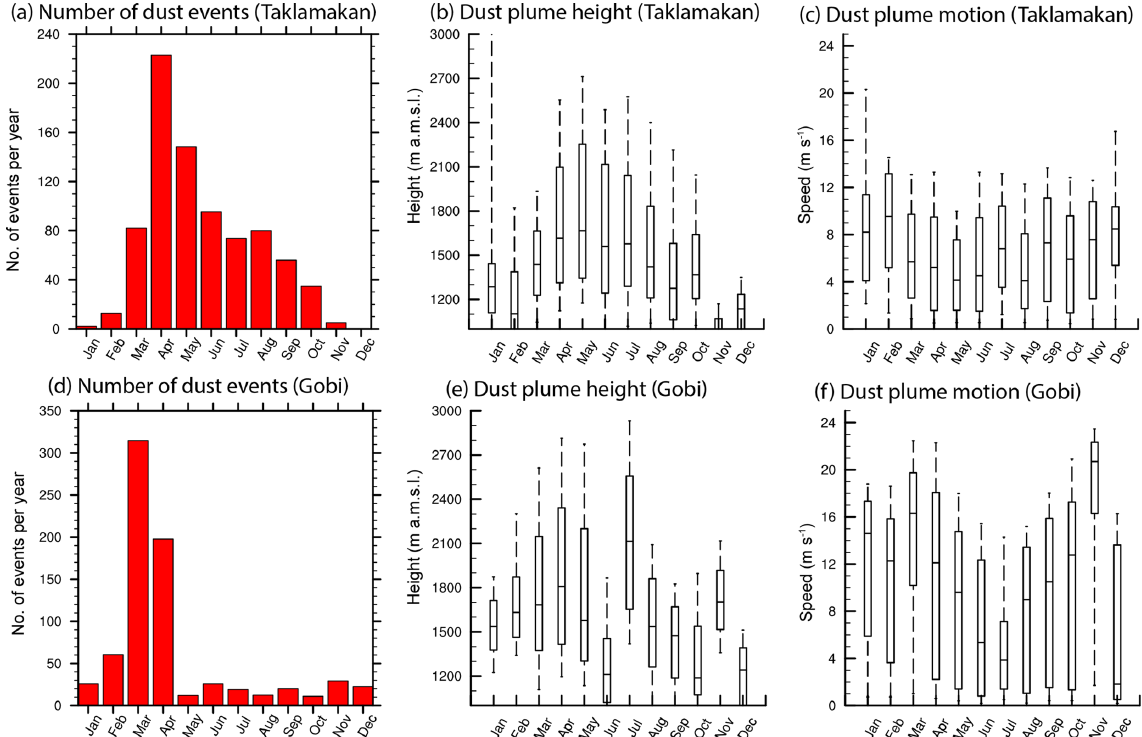
Figure 4. Seasonality in dust plume characteristics from MINX dust plume data. (a, d) Dust plume occurrence per year bar chart, (b, e) injec- tion height box plot (10th, 25th, 50th, 75th, and 90th percentiles), and (c, f) plume top moving speed box plot, across the (a–c)